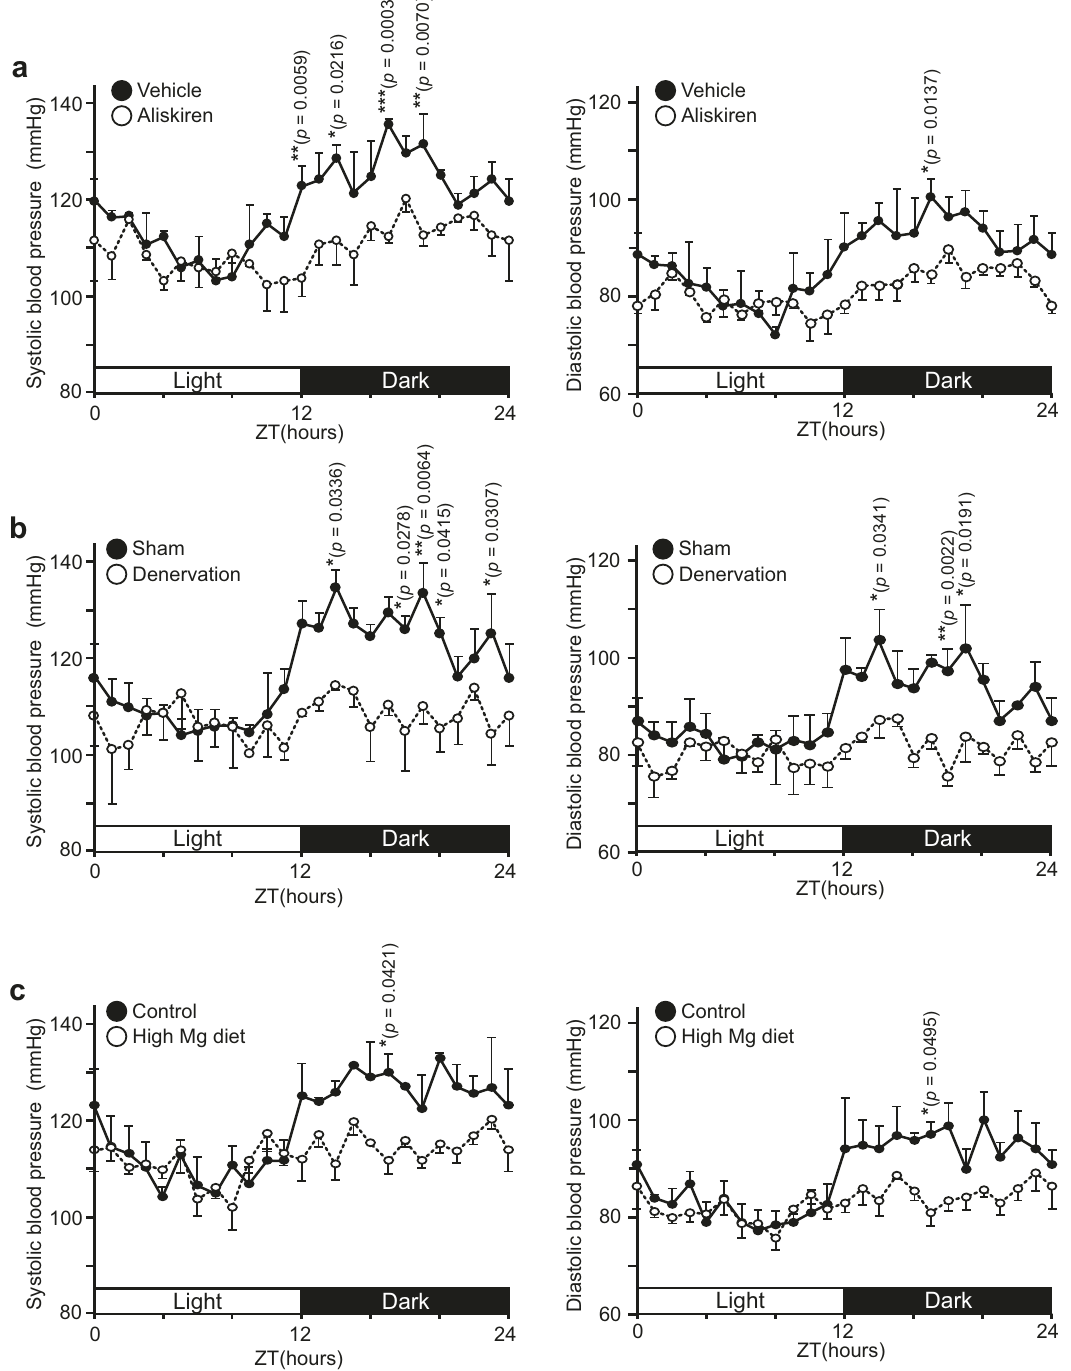
Fig. 6 Effect of arti fi cial intervention on circadian rhythms of blood pressure. 2- to 4-month-old WT mice were ( a ) administered with 25 mg/kg/day aliskiren via subcutaneously embedded osmotic minipump, b subjected to renal denervation, or c fed high-Mg diet, and blood pressure values were measured with radiotelemetry. Data are shown as means ± SEM for systolic (left) and diastolic (right) pressure values ( n = 3 mice for each condition). The p -values were determined by two-way ANOVA with Holm-Sidak post hoc tests. * p < 0.05, ** p < 0.01, *** p <